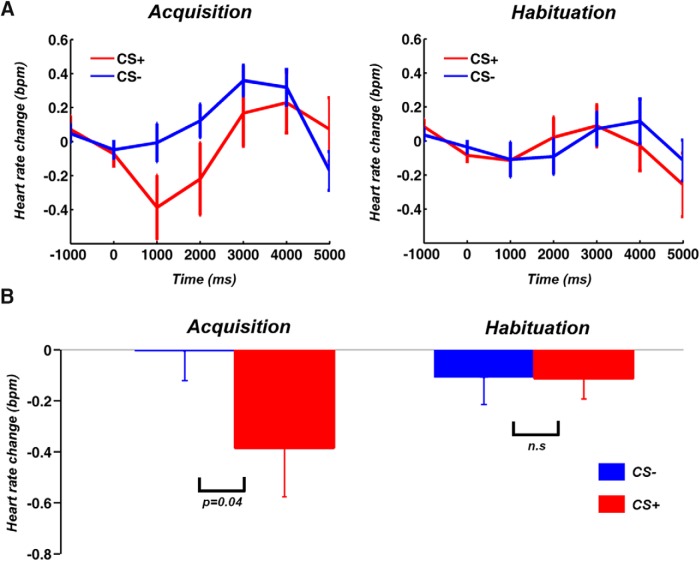
HR responses. A, HR was more decelerated following CS+ compared to CS– during acquisition; no such difference was observed during habituation. B, The HR difference during acquisition was statistically significant at p < 0.05. BPM, beat per minute.